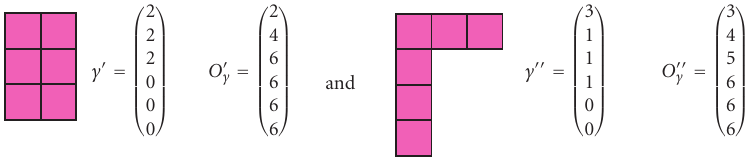
Figure 4.6. Two incomparable diagrams (see Figure 4.5 for n = 6) are shown together with their cor- related partition vectors γ (cid:11) and γ (cid:11)(cid:11) and the vectors O (cid:11) γ and O (cid:11)(cid:11) γ of the corresponding partial